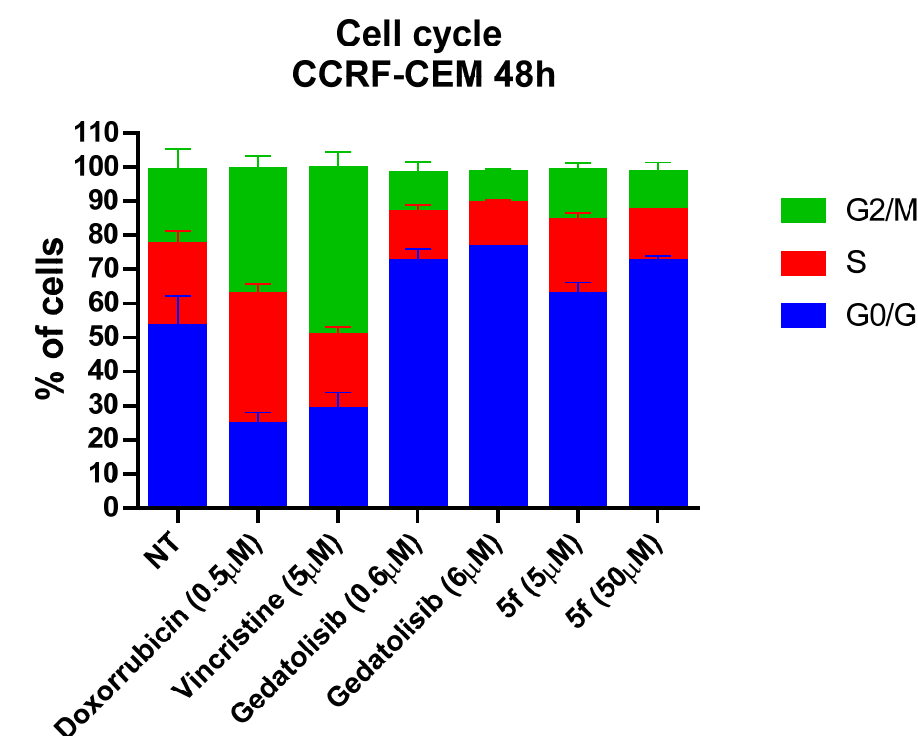
Figure 6. Cell cycle assessment by LASSBio-2252 ( 5f ) and the standards doxorubicin, vincristine and gedatolisib on CCRF-CEM cell line in 48 h. Data presented as mean ± standard error of the mean of three independent experiments.